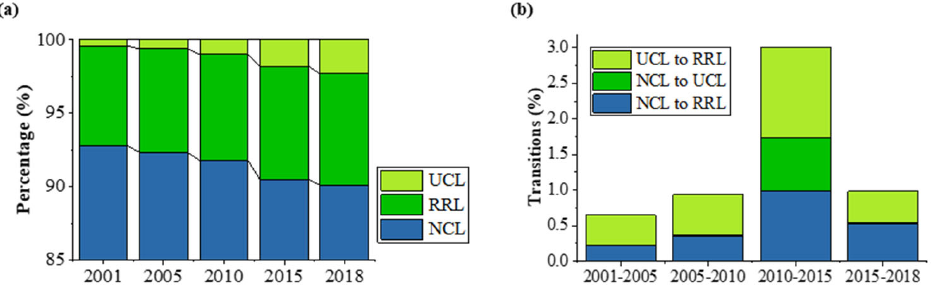
Figure 3. Land transitions and the corresponding statistics ( a ) percentage of the area of UCL, RRL and NCL, respectively, ( b ) transition percentage From UCL to RRL, NCL to UCL and NCL to RRL, respectively.